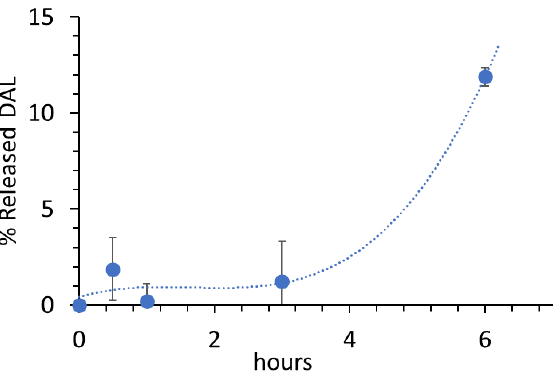
Figure 2. Percentage of DAL released from DAL-NP vs. time in phosphate-buffered saline (PBS). Data are the means ± standard deviation (SD) of two independent experiments.